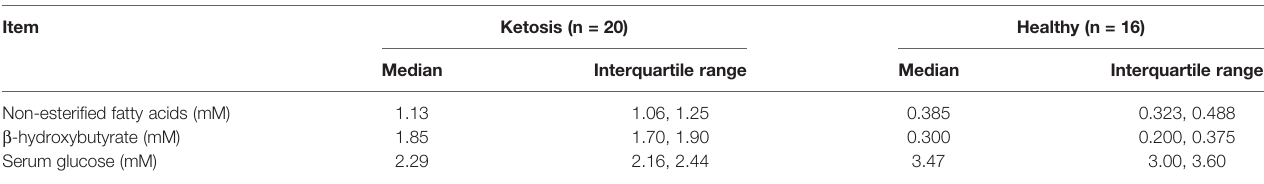
TABLE 1 | Blood biomarker concentrations in healthy cows and cows with ketosis.